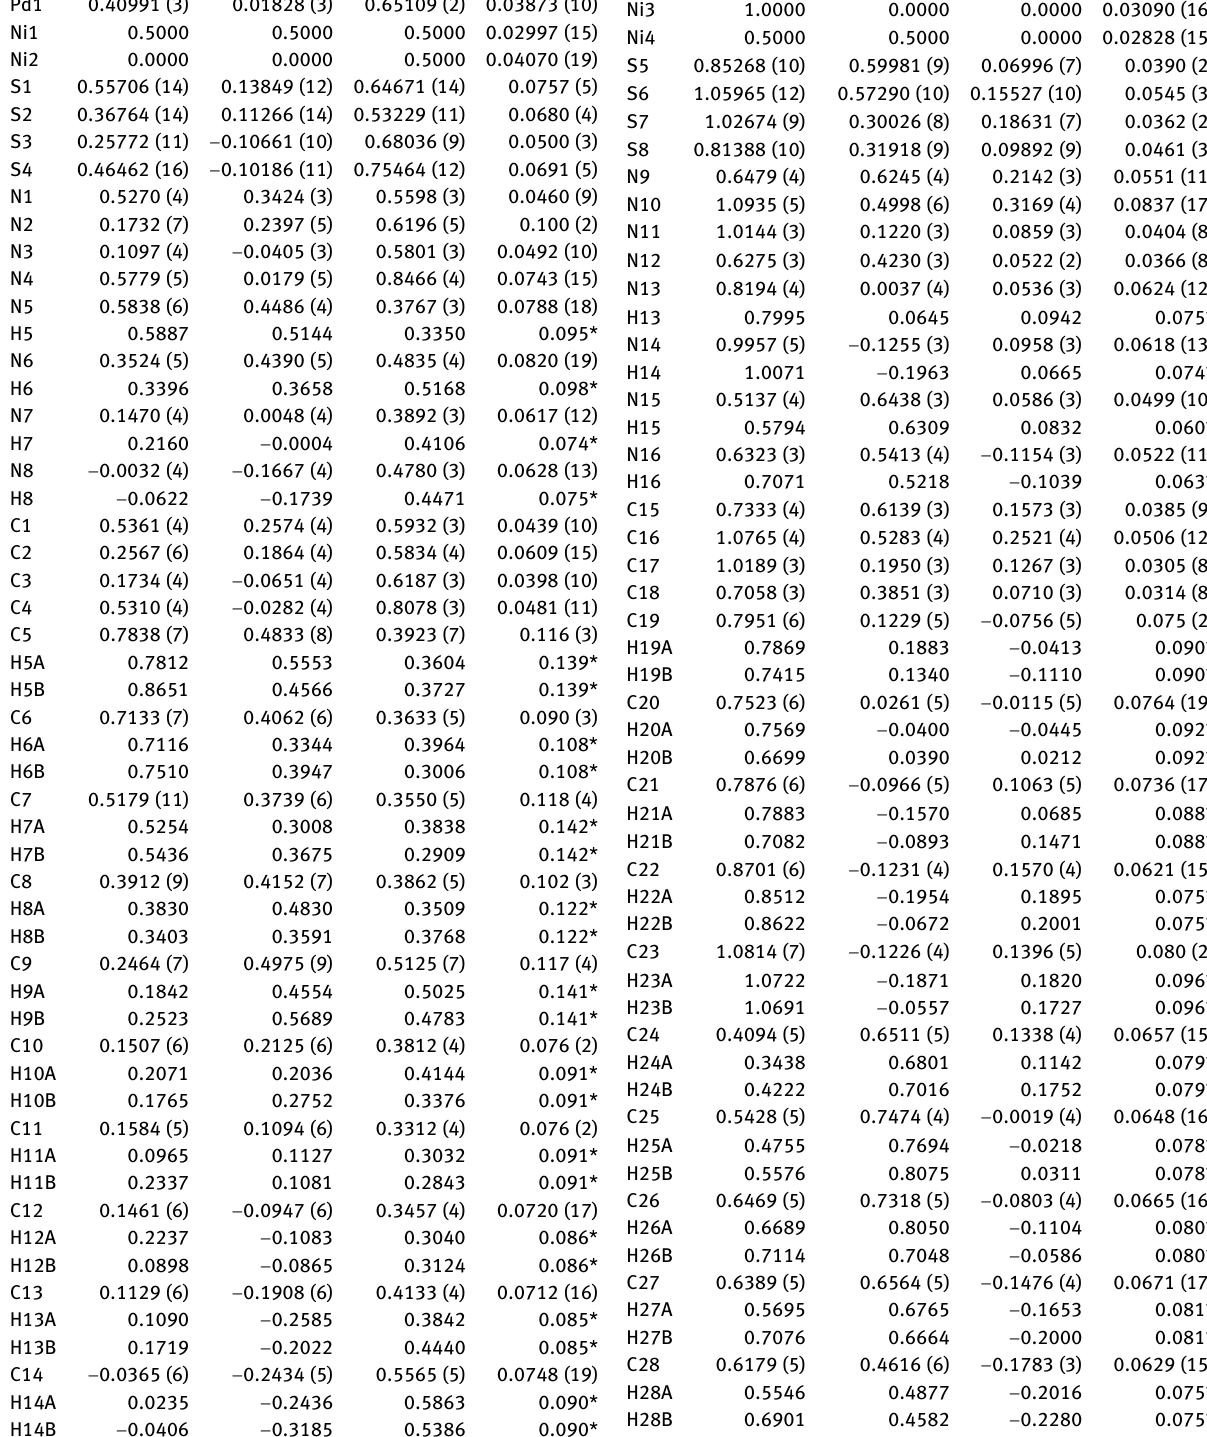
Table  : Fractional atomic coordinates and isotropic or equivalent isotropic displacement parameters (Å 